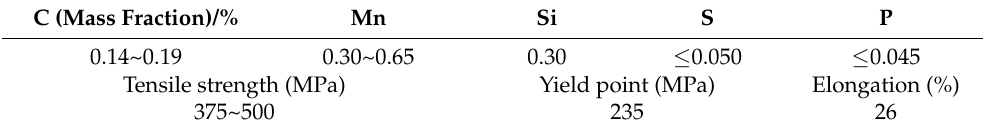
Table 2. Material properties of